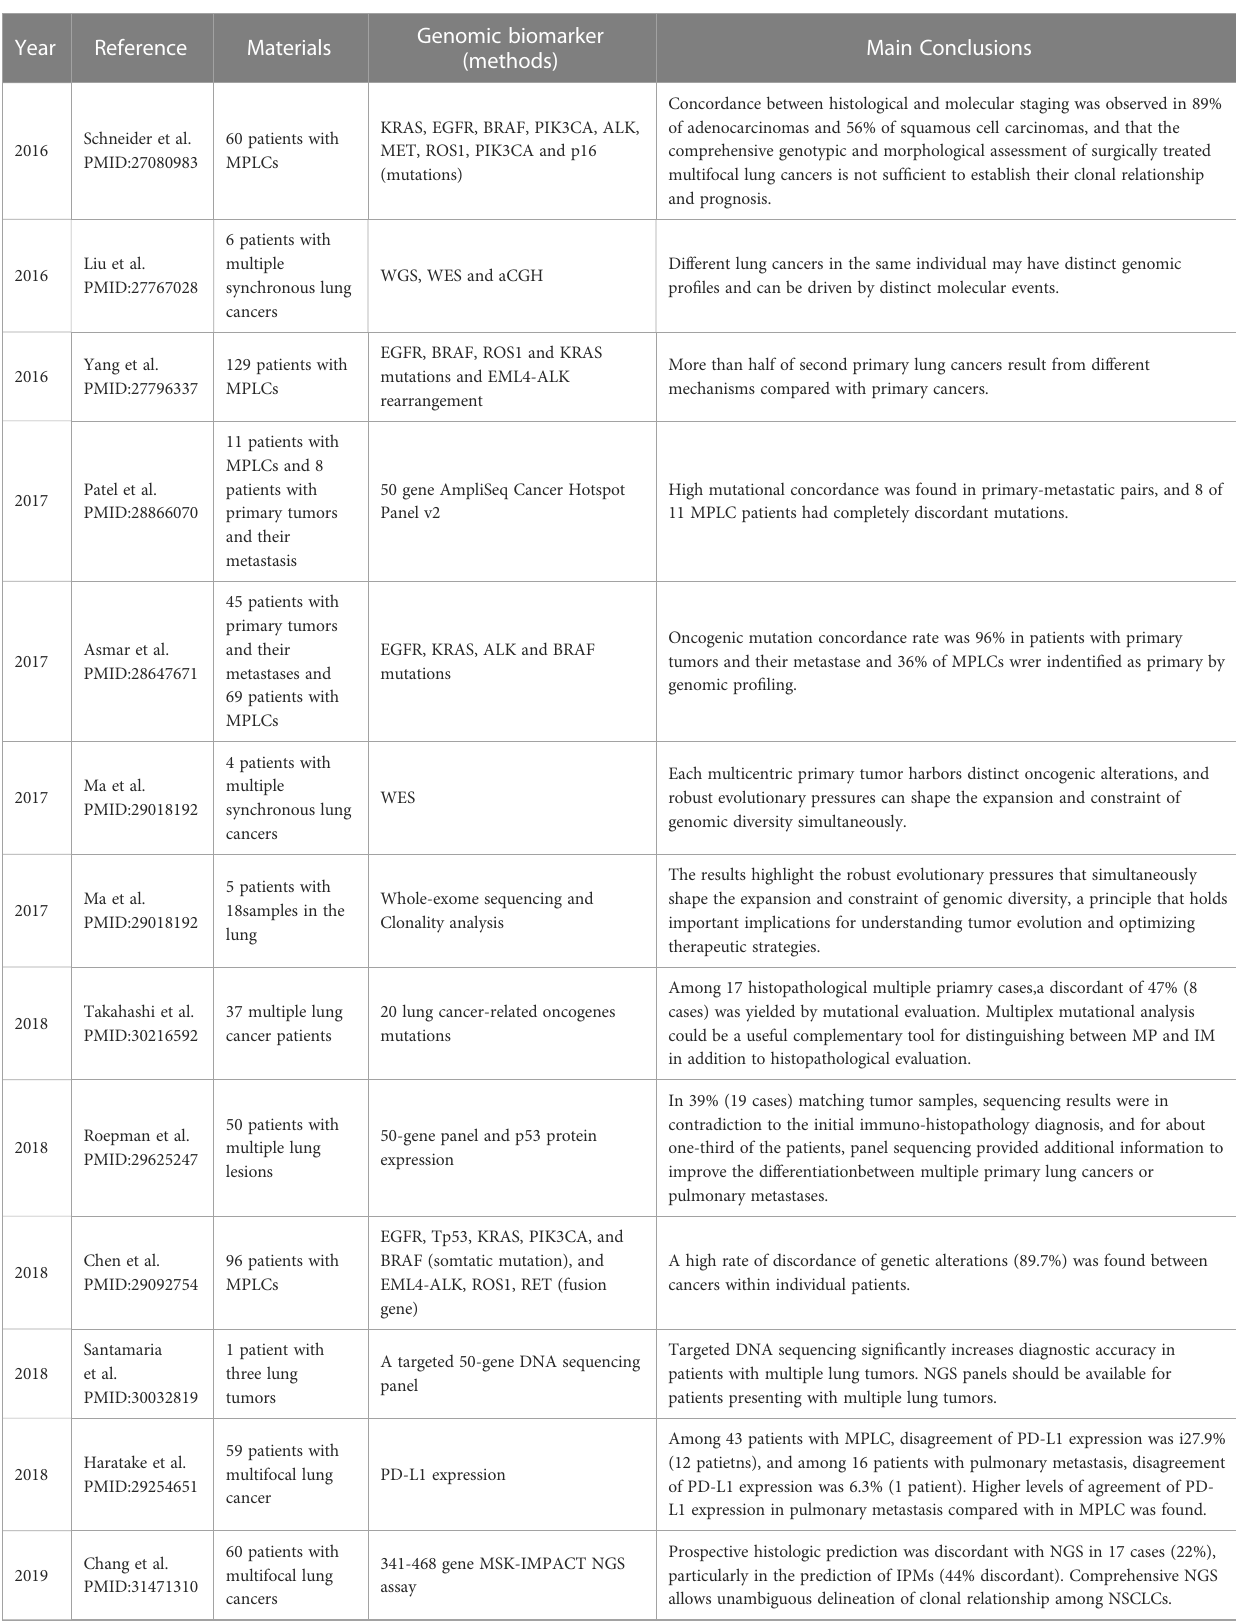
TABLE 4 Representative genomic and molecular studies on MPLC within the recent 10